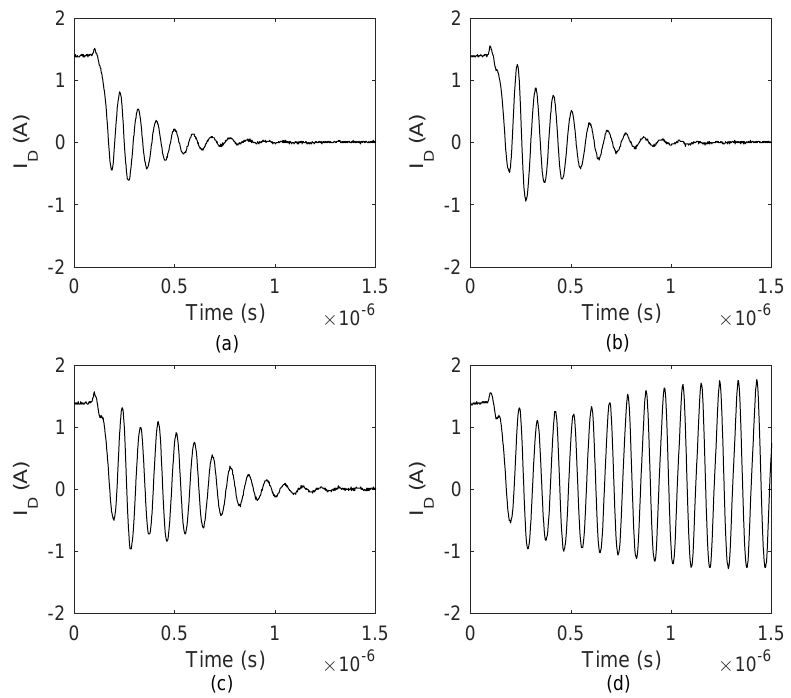
Figure 16. The experimental type I oscillation waveforms of the drain current I D with various L S with R G = 3.6 Ω and L C = 410 nH. ( a ) L S = 26 nH. ( b ) L S = 53 nH. ( c ) L S = 80 nH. ( d ) L S = 97 nH.